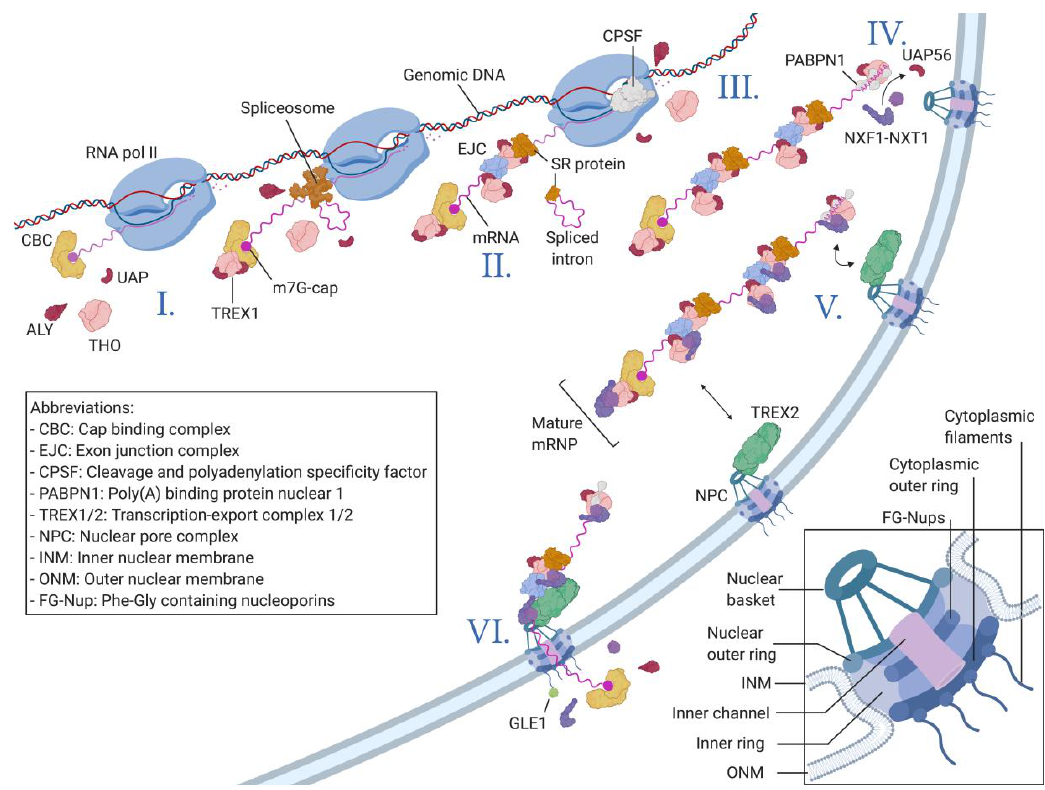
Figure 1. The nuclear RNA processing steps linked to canonical nuclear export. I. RNA polymerase II initiates the transcription of genomic DNA (red and blue helix) and produces a capped transcript (purple). The cap is recognized by the cap-binding complex (CBC). The TREX core complex THO and the adapters ALY (Ally of AML-1 and LEF-1) and UAP56 assemble at the CBC. II. The spliceosome assembles at the splicing sites of nascent mRNA and promotes the intron excision. The exon junction complex (EJC) is deposited 23 nt upstream of the splicing site where the Serine-Arginine-rich (SR) proteins remain attached to the mRNA. TREX1 interacts with the EJC and SR proteins. III. The cleavage and polyadenylation specificity factor complex (CPSF) cleaves the nascent mRNA at the termination sites and promotes the synthesis of the poly(A) tail. IV. Nuclear RNA export factor 1 (NXF1)–NTF2-related export protein 1 (NXT1) exportins are recruited by the TREX1 complex starting at the 3′ end of the mature mRNP. V. NXF1–NXT1 interacts with TREX2 to direct the mature mRNP towards the nuclear pore complex (NPC) where the mRNP is exported through the interaction of NXF1–NXT1 with FG-Nups inside the NPC pore VI. During export, many protein components of the mRNP are removed, while others dissociate from the mRNA in the cytoplasm and are recycled to the nucleus. The square in the bottom right corner shows a more detailed representation of the